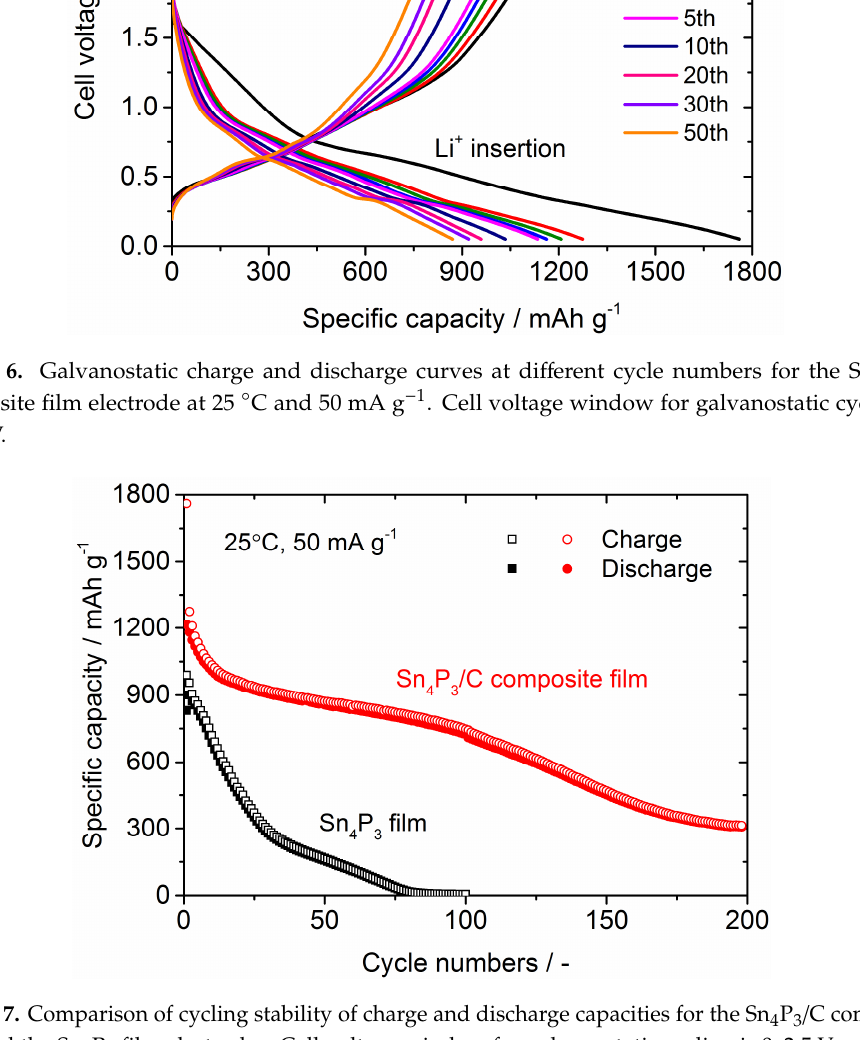
Figure 7. Comparison of cycling stability of charge and discharge capacities for the Sn 4 P 3 / C composite film and the Sn 4 P 3 film electrodes. Cell voltage window for galvanostatic cycling is 0–2.5 V.